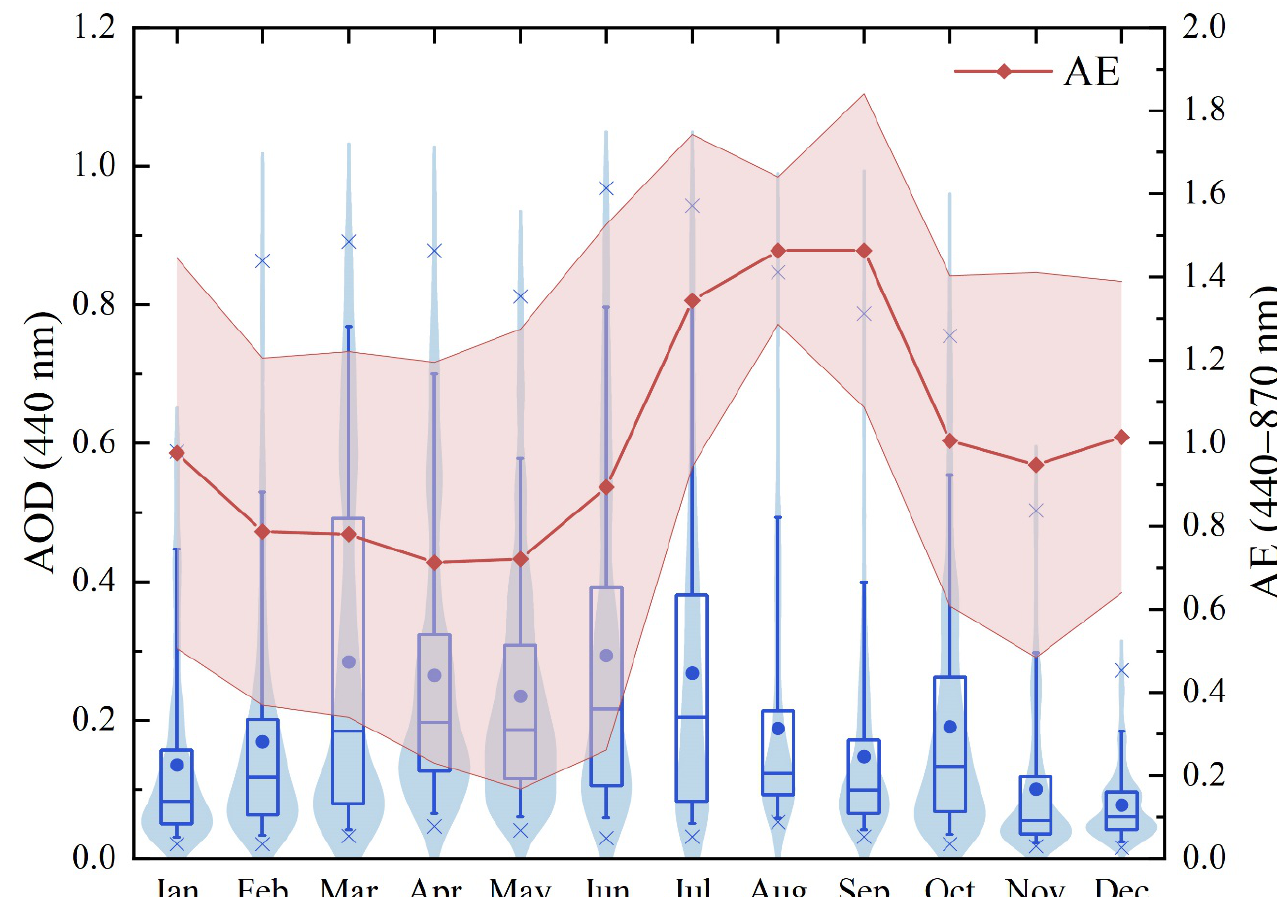
Figure 2. Monthly mean AOD 440 nm and the Ångström exponent (AE) (440−870 nm) at the MFYD Observatory from 2013 to 2019. The blue circles and central lines indicate the mean and median values of the AOD and the blue shaded area and cross sign represent the density distribution and the 99th percentile of the AOD. The red diamonds indicate the mean Ångström exponent and the red shaded area represents the standard deviation.